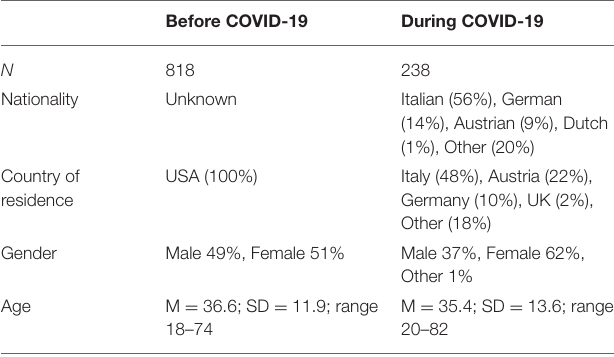
TABLE 1 | Demographics of the samples that rated valence and arousal of the stimulus images before (Kurdi et al., 2017; left column), and during the COVID-19 pandemic (current study; right column).